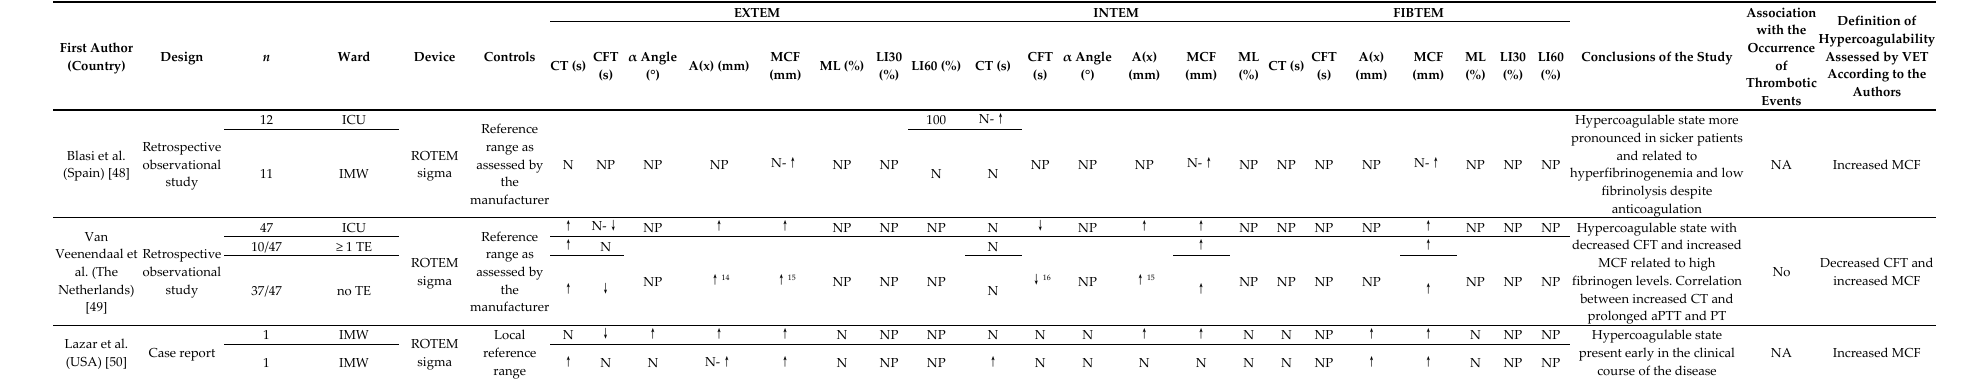
Table 5. Main findings of studies reporting ROTEM results (except APTEM and TEM-tPA